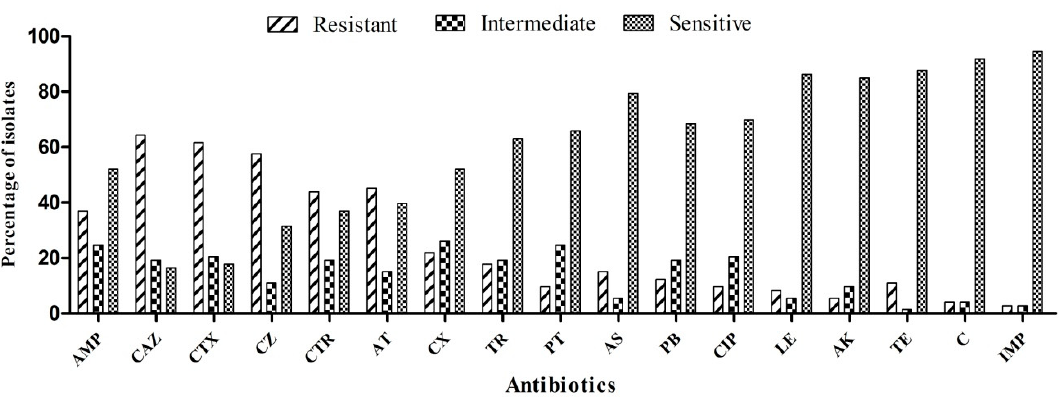
Figure 1. Antibiotic susceptibility pattern of extended-spectrum β -lactamases (ESBL) producing bacterial strains used in this study. Note 1: AMP, ampicillin; CAZ, ceftazidime; CTX, cefotaxime; CZ, cefazolin; CTR,ceftriaxone; AT,aztreonam; CX,cefoxitin; TR,trimethoprim; P / T-piperacillin / tazobactam,